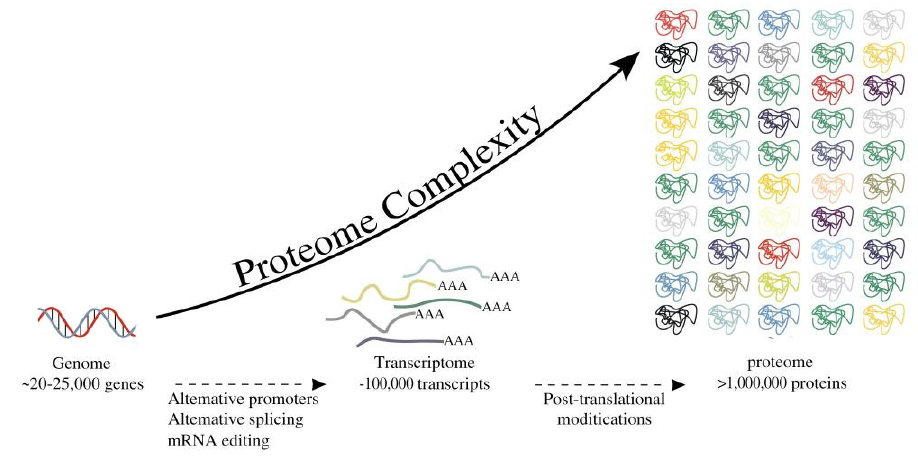
Figure 2. The entire process from gene to protein.